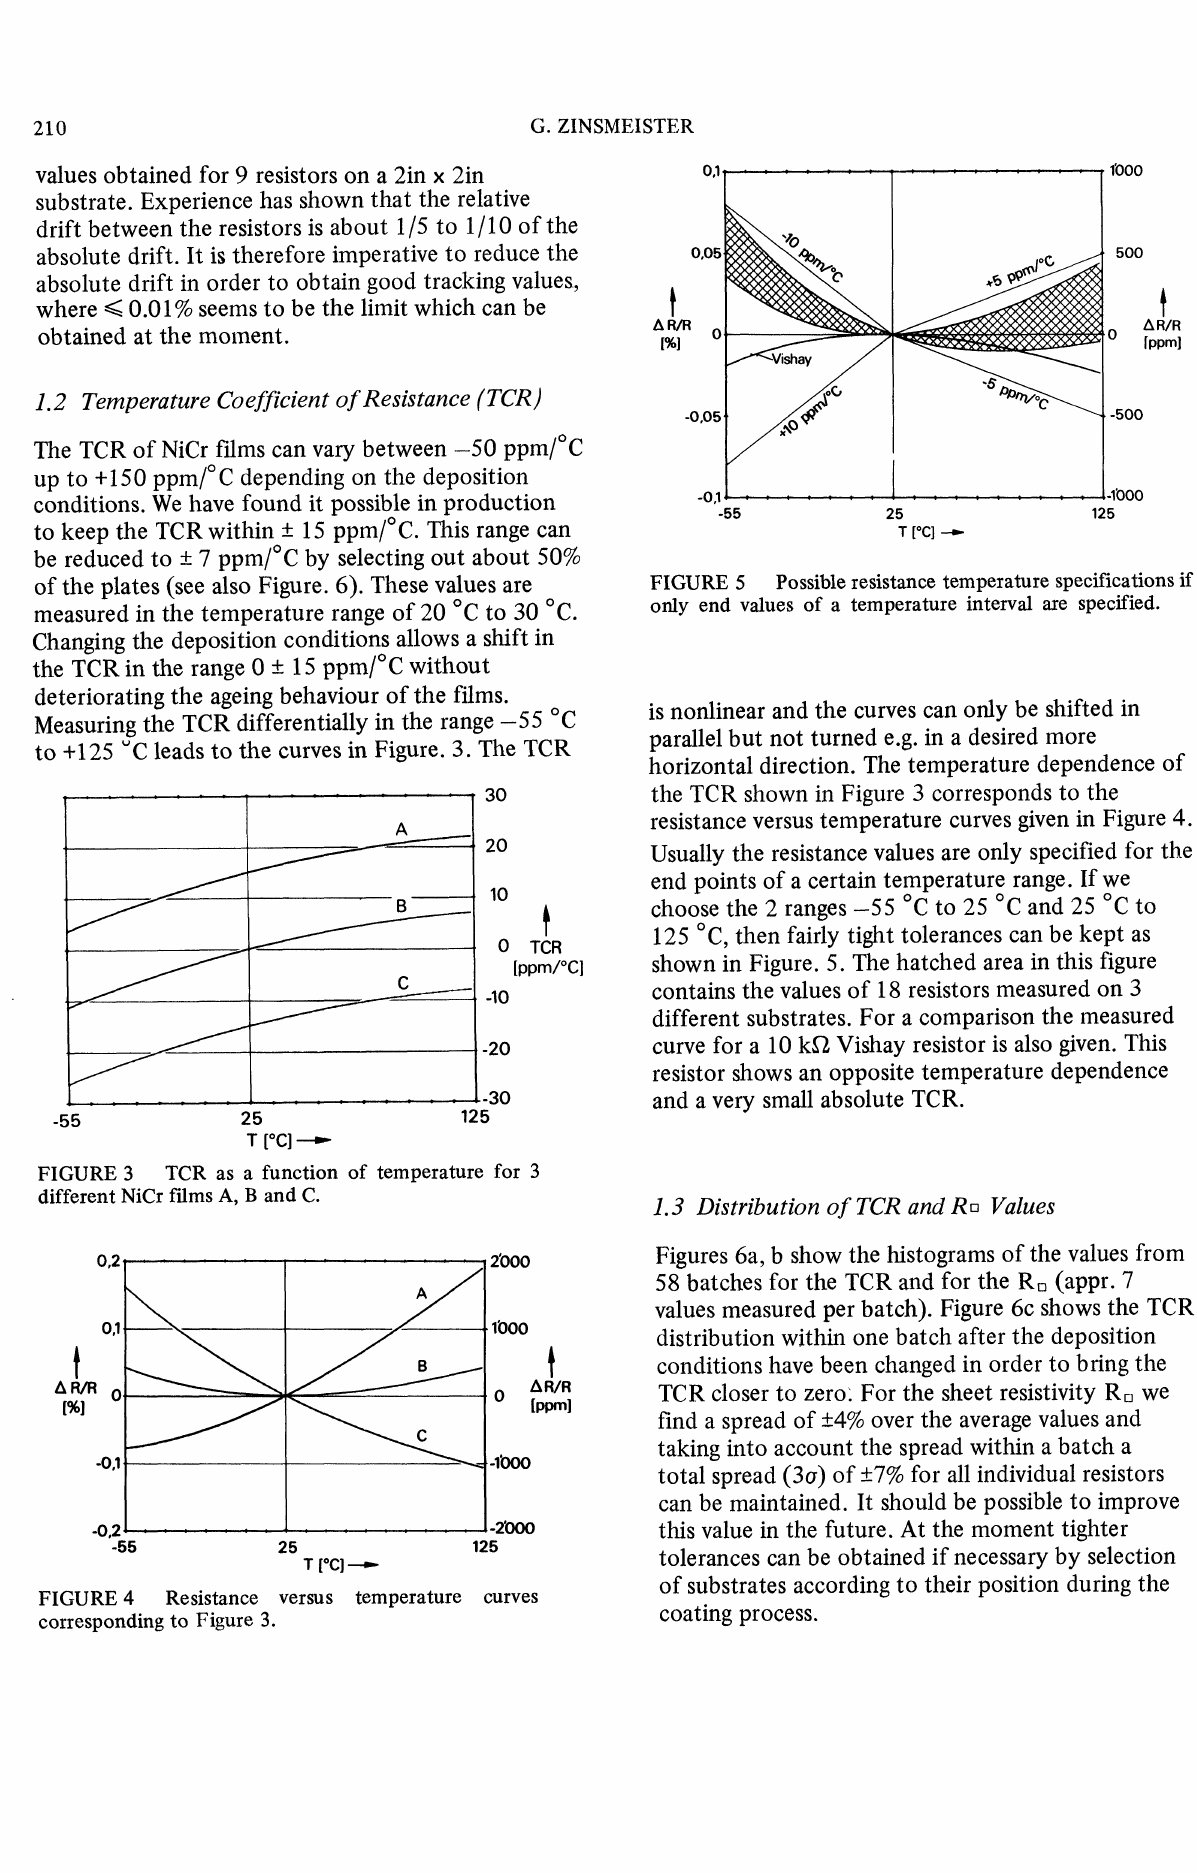
Resistance versus temperature curves corresponding to Figure 3.